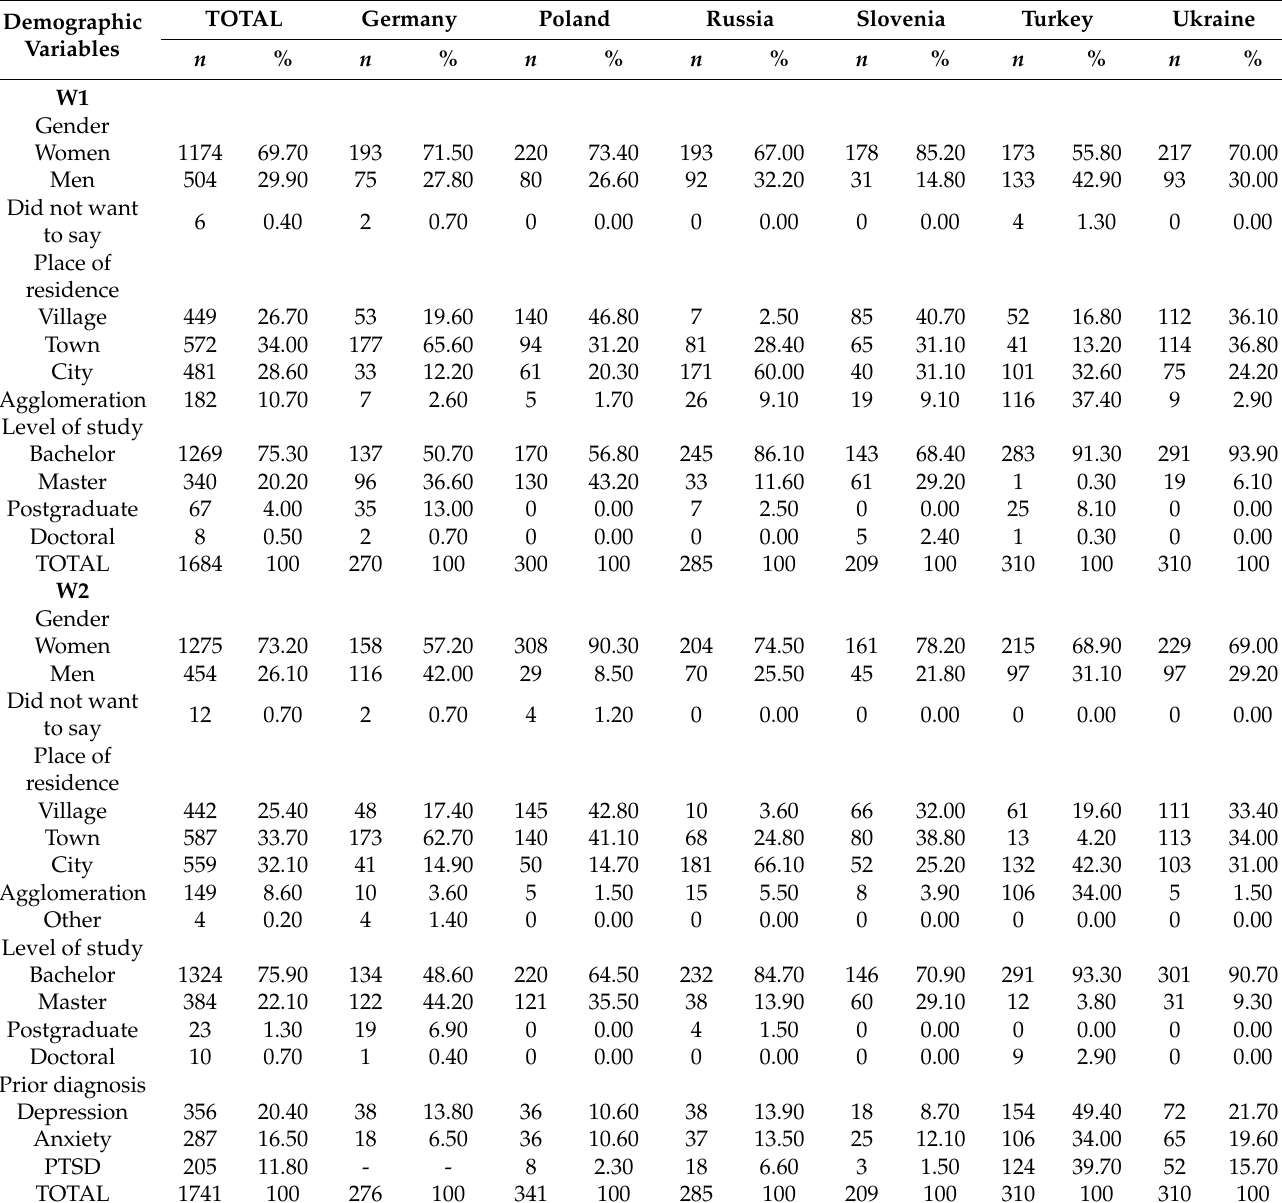
Table 1. Sociodemographic characteristics and previous diagnosis of depression, anxiety, and PTSD of the study sample in the six